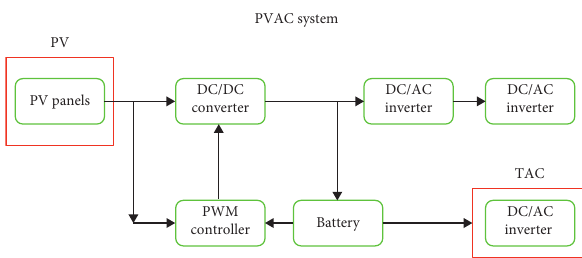
Figure 1: Block diagram of the PVAC